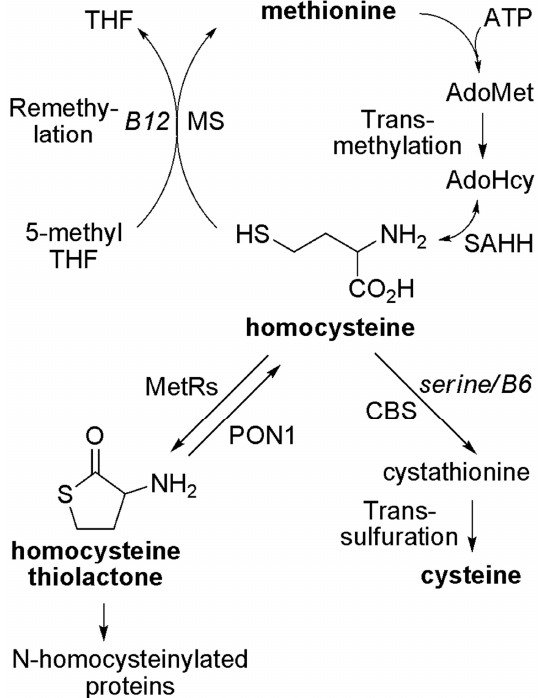
Figure 1. Metabolism of homocysteine in mammals. AdoHcy, S -adenosylhomocysteine; AdoMet, S -adenosylmethionine; ATP, adenosine-5 ′ -triphosphate; CBS, cystathionine β -synthase; Hcy, homocysteine; Hcy TL, homocysteine thiolactone; MetRS, methionyl-tRNA synthetase; MS, methionine synthase; PON1, paraoxonase 1; SAHH, S -adenosylhomocysteine hydrolase; THF,